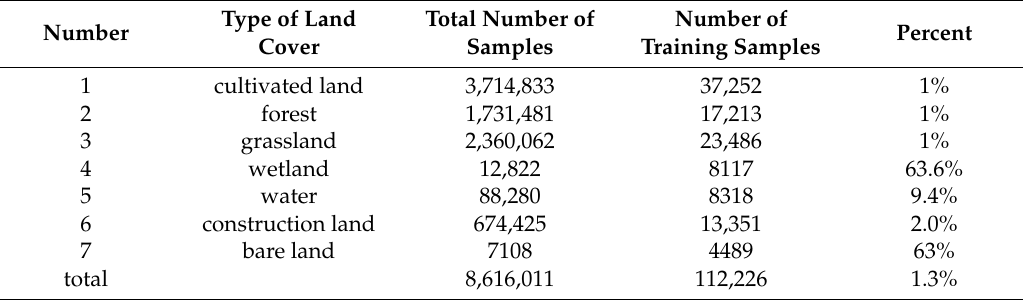
Table 1. Numbers of samples of different land cover types in